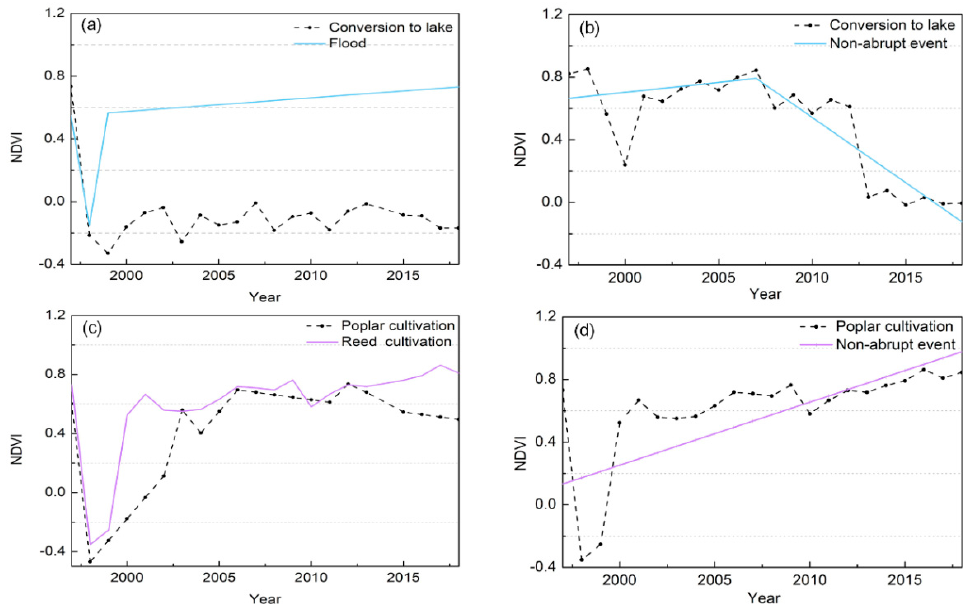
Figure 10. Four types of commission errors possible when assessing cropland conversion with LandTrendr: ( a ) transient floods misclassified as conversion to lake; ( b ) non-abrupt conversion to lake; ( c ) reed cultivation producing a similar NDVI signal as poplar cultivation; ( d ) non-abrupt poplar cultivation. The typical trajectory for each error (blue or purple solid line) and real cropland conversion (black dotted line) were extracted from NDVI series.